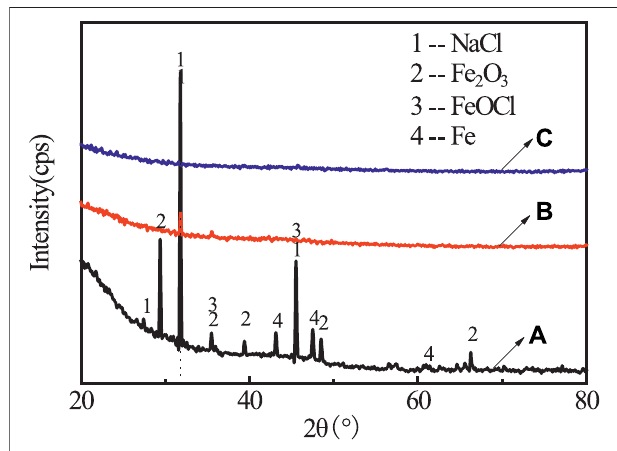
FIGURE 1 | The IR spectra for rusty carbon steel (A) , PA dropped on rusty carbon steel (B) ,and PA/G/EP coating coated onrustycarbon steel (C) .